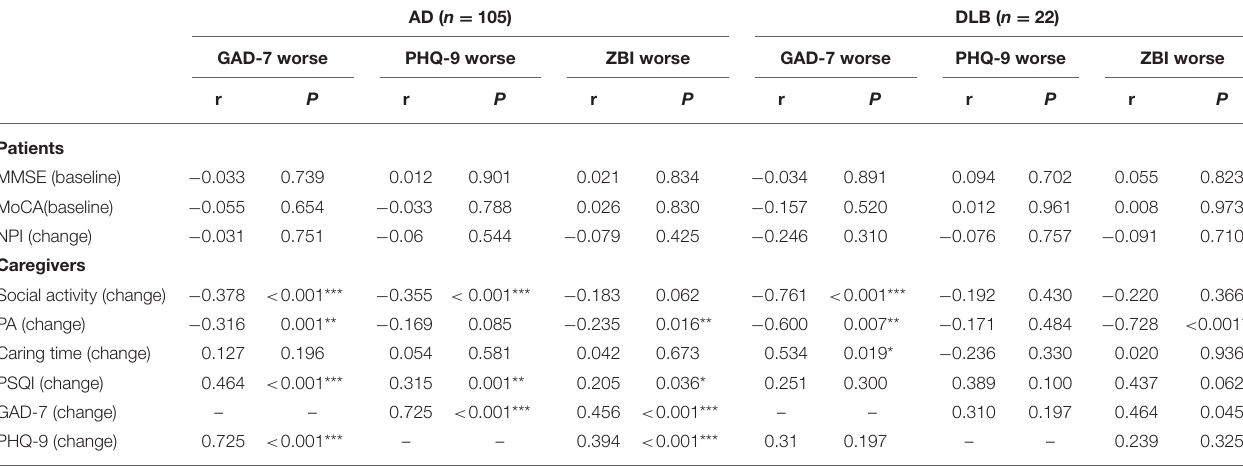
TABLE 3 | Correlation of worsened GAD-7, PHQ-9 and ZBI with hypothesized related factors in the AD and DLB